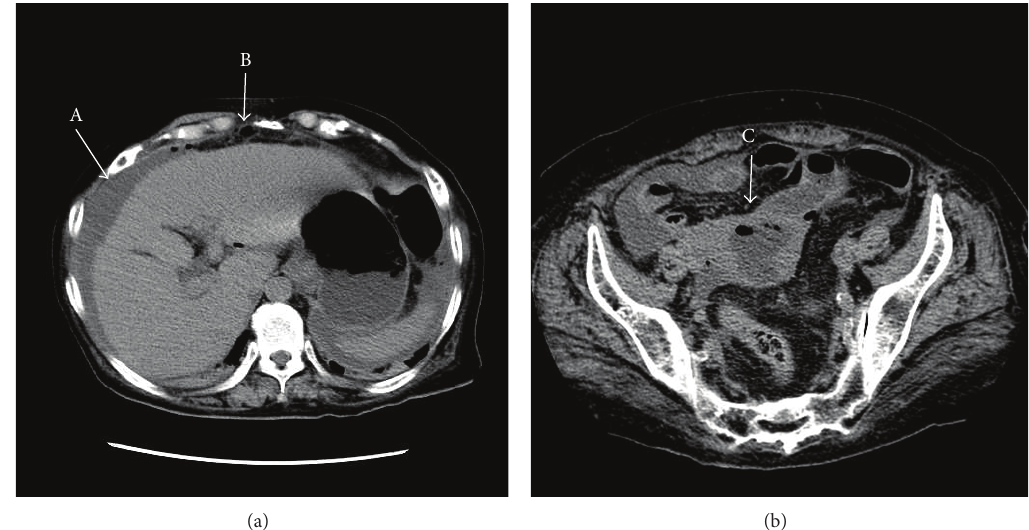
Figure 1: Transverse views of computed tomography showing the presence of fluid (A) and free air (B) in the upper abdomen (a) and a fluid filled uterus and intrauterine free air (C)